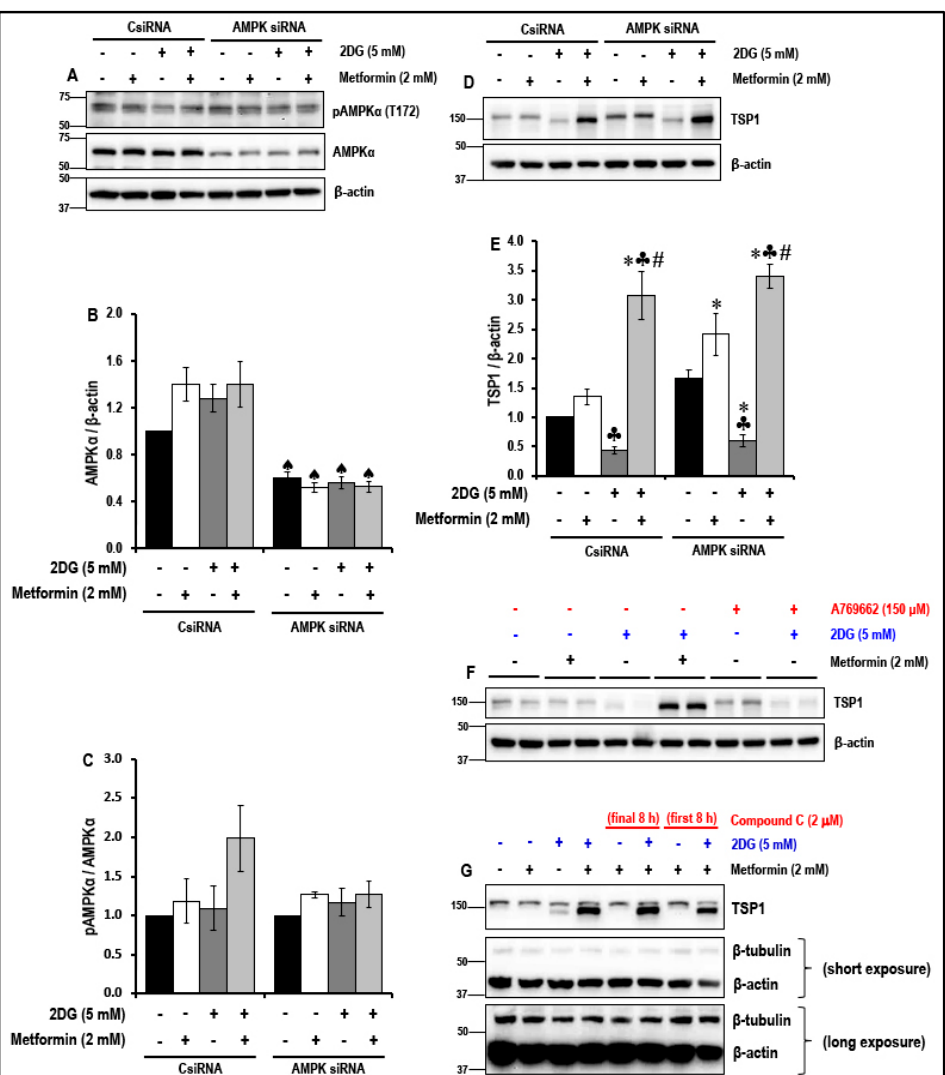
Figure 5. 5' Adenosine Monophosphate-Activated Protein Kinase (AMPK) knockdown and its effect on the levels of TSP1 in metformin-treated normal glucose and 2DG-exposed MMECs (48 h): Representative Western blots ( A ) show the levels of pAMPK α (T172) and AMPK α in control siRNA-treated and AMPK siRNA-treated cells. Bar graphs ( B ) and ( C ) represent the ratio of pAMPK α (T172)/AMPK α and AMPK α / β -actin in the cells (normalized with β -actin loading controls). Representative Western blots ( D ) show the levels of TSP1, respectively, after 48 h in culture. Bar graphs ( E ) represent the levels of TSP1 (normalized with β -actin loading controls) in the cells. Representative Western blots show the levels of TSP1, ( F ) in the presence of metformin and A769662 (150 μ M, a putative activator of AMPK), and ( G ) in the presence of metformin and dorsomorphin/compound C (2 μ M, a widely used pharmacological inhibitor of AMPK) after 48 h in culture. ♠ p < 0.05 indicates significance when the AMPK α levels in AMPK siRNA-treated cells were compared to its respective group control siRNA-treated cells, * p < 0.05 indicates significance when compared to non-treated controls, ♣ p < 0.05 indicates significance when compared to control + 2 mM metformin-treated cells and # p < 0.05 was considered significant when compared to 2DG (5 mM)-treated cells.